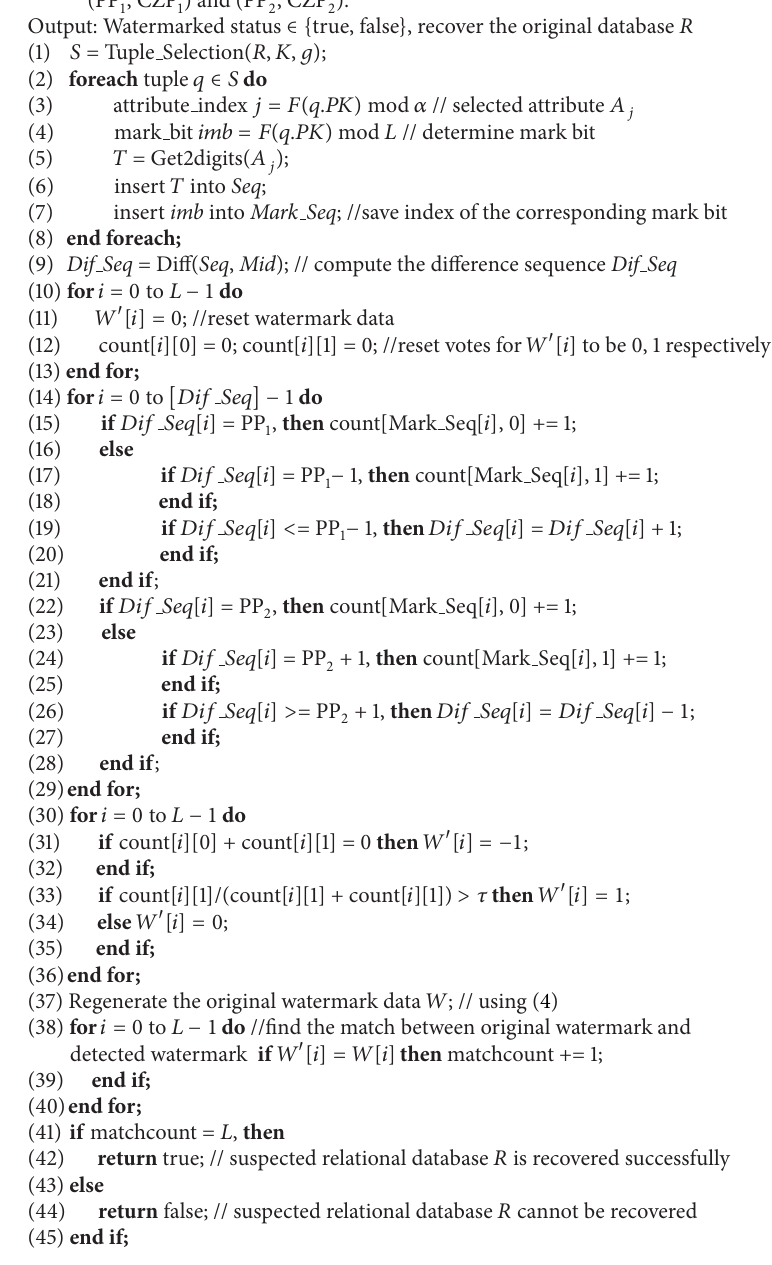
Algorithm 3: Watermark